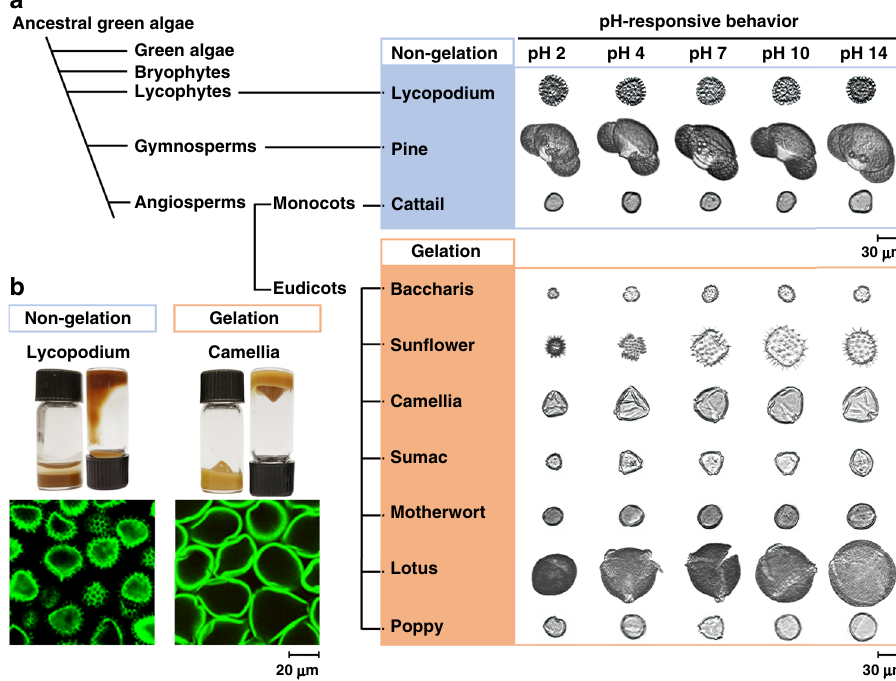
Fig. 4 Plant kingdom sampling to identify other types of chemically tractable pollen. a Evolutionary cladogram of plant pollen sources including lycophytes, gymnosperms and angiosperms with corresponding DIPA images as a function of pH response. b Top: Photographs of pollen dispersion in upright and reversed vials, showing the response of pollen gels to gravity. Bottom: Cross-sectional CLSM images of treated particles in cases where particles interact to form a microgel and where particles remain as discrete, individual